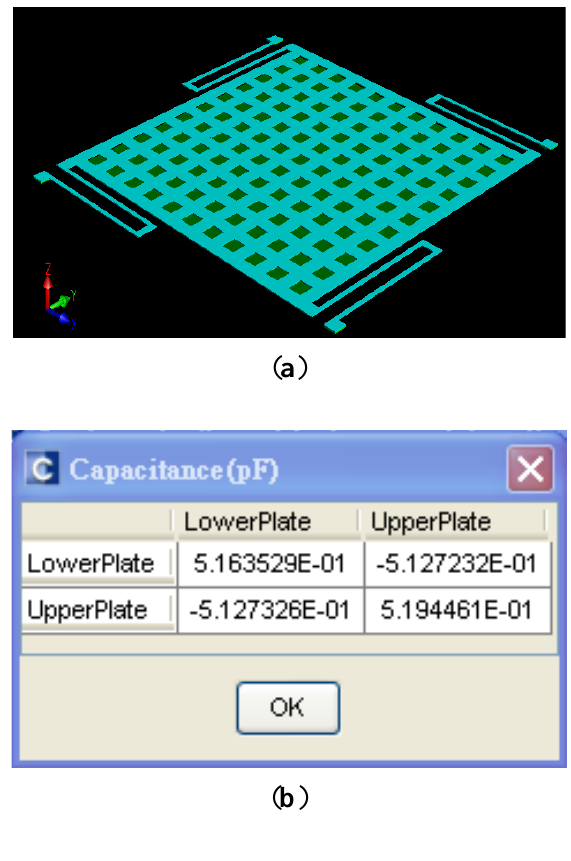
Figure 10. Using the CoventorWare simulator to solve C gyroscope. ( b ) Simulation